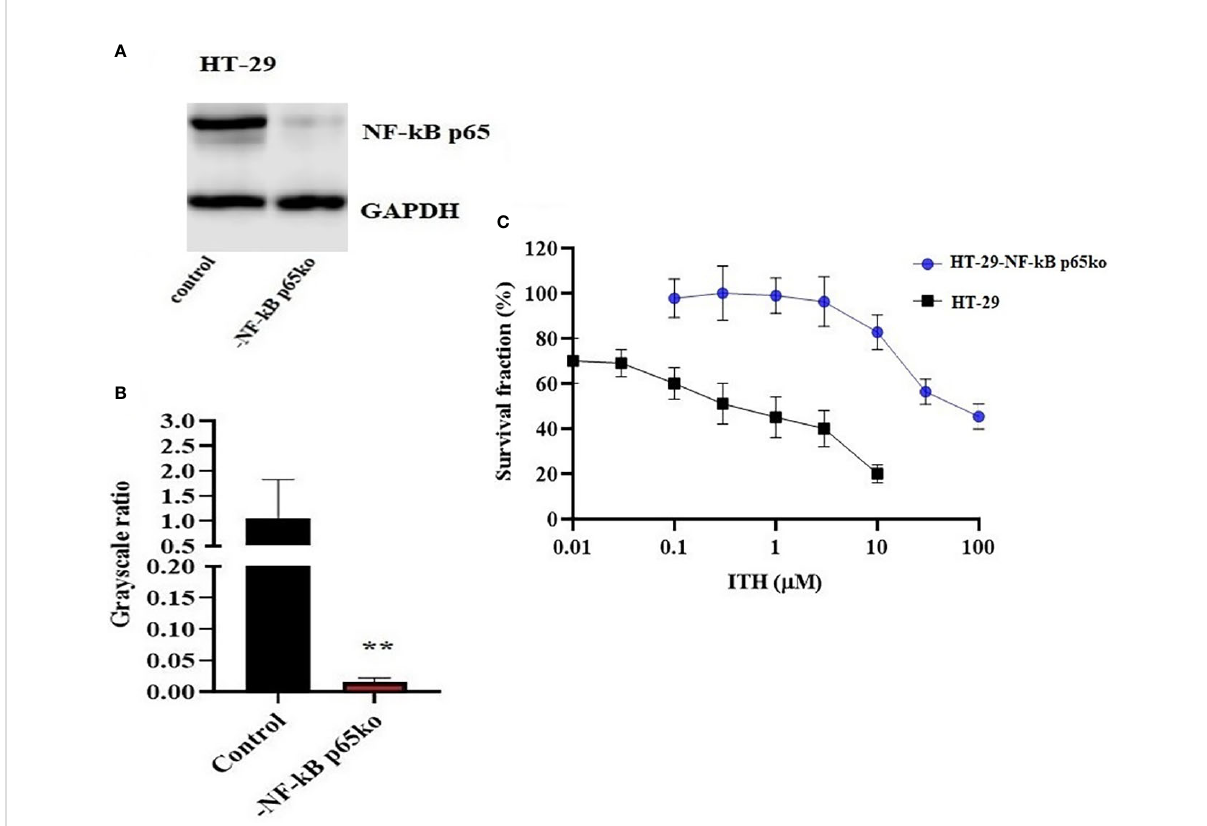
FIGURE 7 Con fi rmation of NF- k B p65 knockout in HT-29-NF- k B p65ko cells. (A) Western blotting result of NF- k B p65 protein expression level and (B) relative quanti fi cation of NF- k B p65 in HT-29 and HT-29-NF- k B p65ko cells. The expression level of the target protein was normalized to GAPDH. (C) Survival fraction (%) was measured after treatment with ITH-6 (µM) for 72 hours on HT-29 and HT-29-NF- k B p65ko cells. Points with error bars represent the mean ± SD for independent determinations in triplicate. The fi gures are representative of three independent experiments. ** p <.01 compared with the control